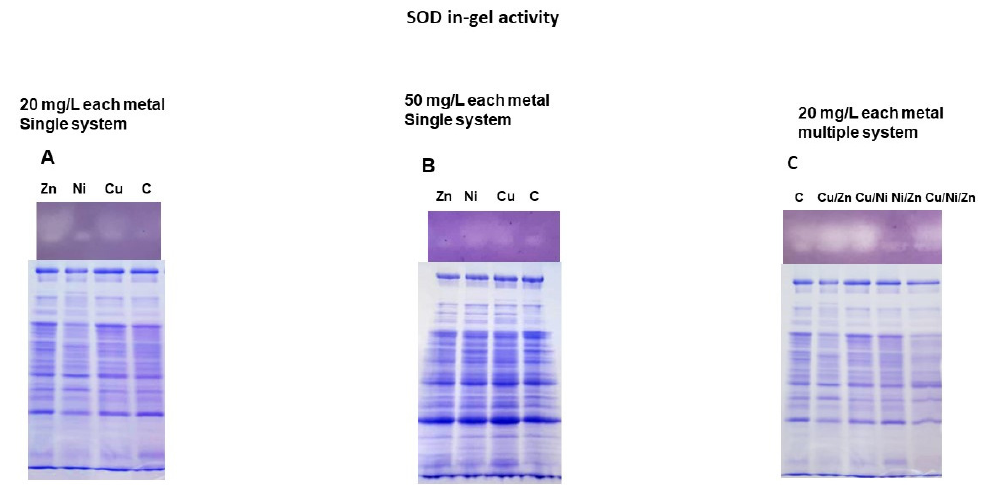
Figure 5. SOD activity in the cell lysate of S. xiamenensis DCB2-1 under zinc, copper, and nickel single ( A, B ) and combination actions ( C ). Metal concentrations in single systems are 20 and 50 mg/L; metal concentrations in complex systems are 20 mg/L. C—Control sample.